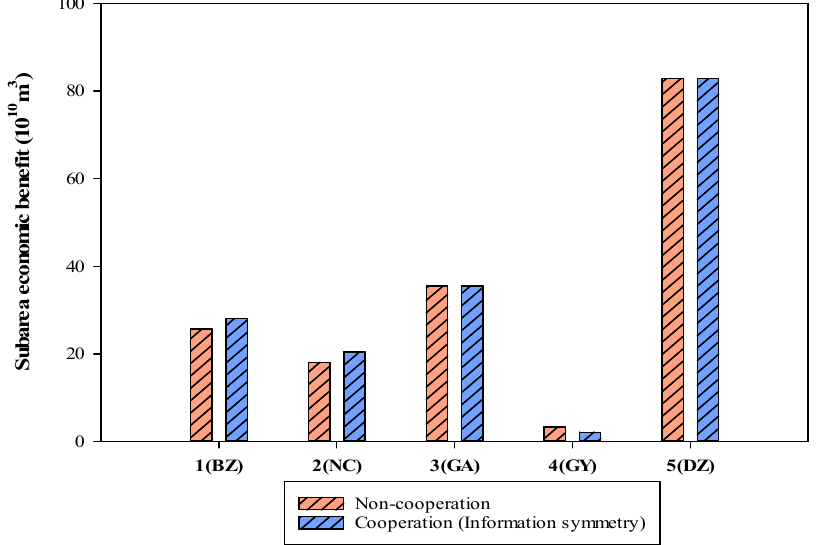
Figure 3. Economic benefit of sub-regions under non-cooperation and cooperation (symmetric information).